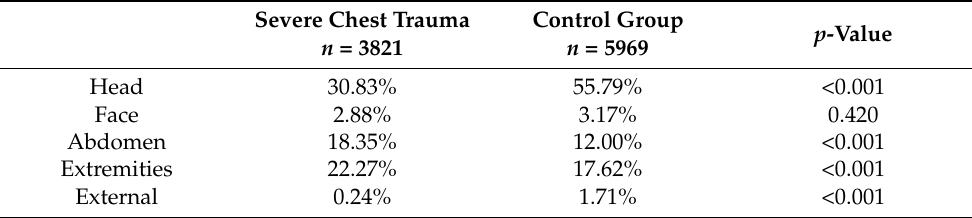
Table 2. Percentage of patients with AIS ≥ 3 in the different areas in the severe chest trauma and control groups.